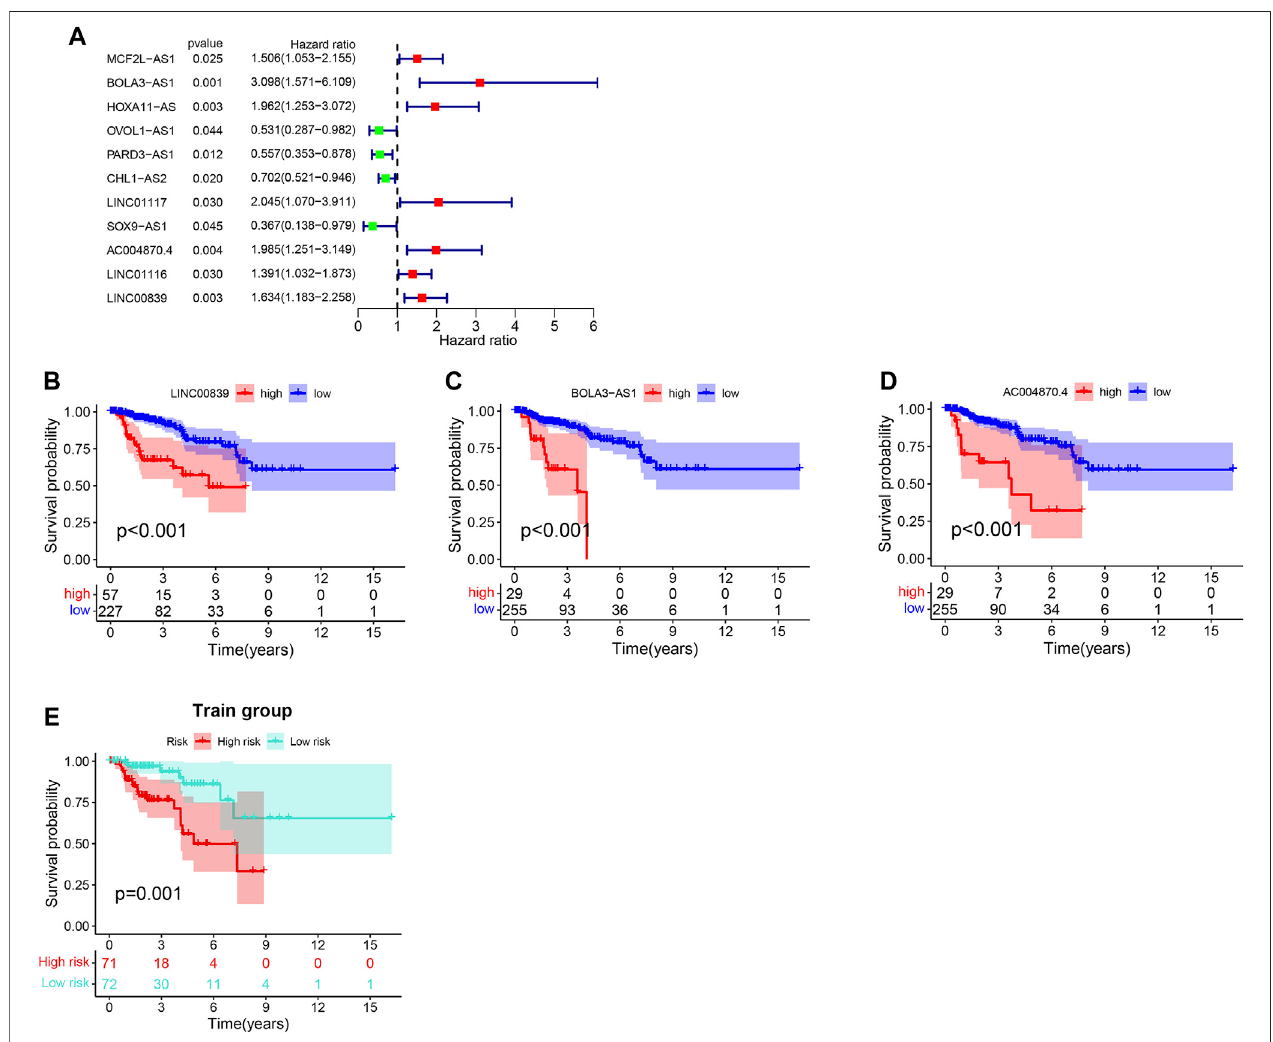
FIGURE3| ConstructionofGILncSigforoutcomepredictioninthetrainingset. (A) .Forestmapofthegenomicinstability-relatedlncRNAsassociatedwithsurvival. (B – D) .Kaplan-Meiercurvesfrom27genomicinstability-relatedlncRNAsinKIRPpatients. (E) .Kaplan – Meiercurvesfordistinctriskgroupsstrati fi edbasedonGILncSigin the training